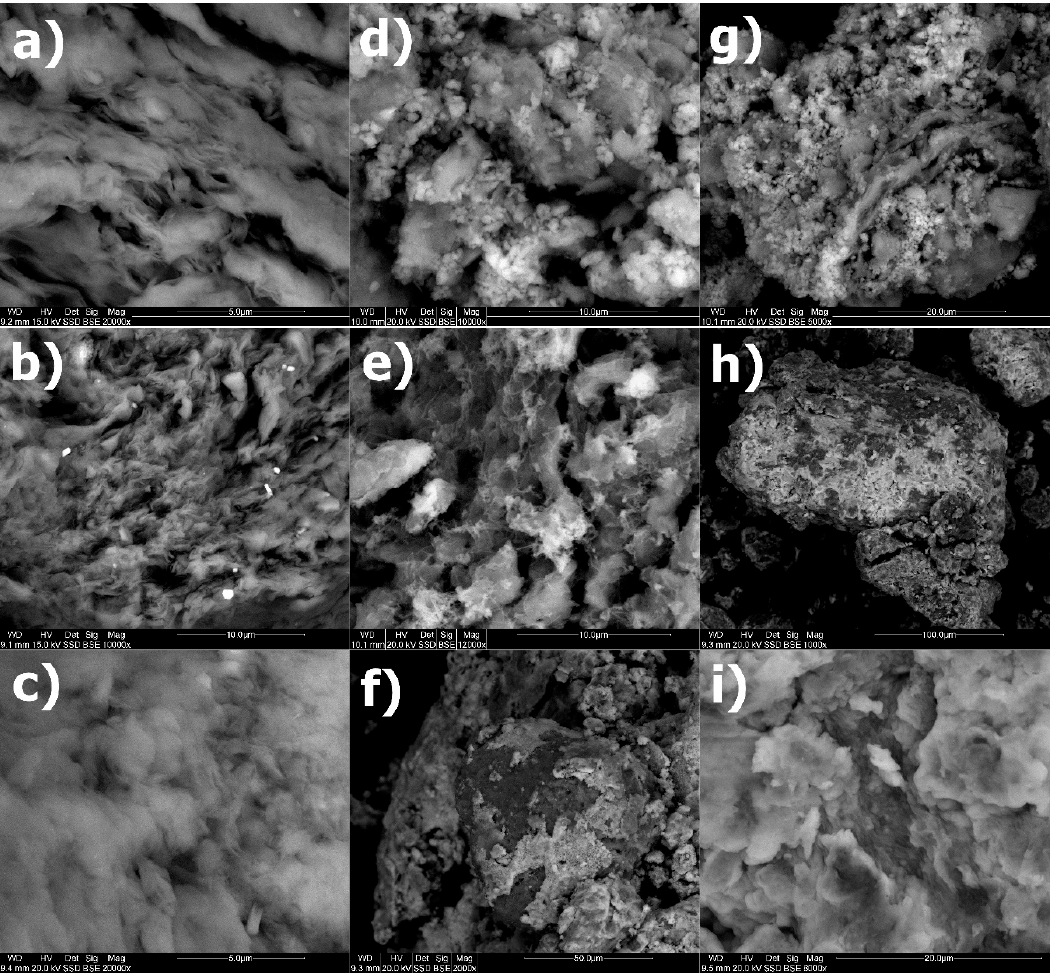
Figure 6. SEM images of samples: ( a ) Na-M, ( b ) DDTMA-M, ( c ) DDDDMA-M, ( d ) DDTMA-M-Mo, ( e ) DDTMA-M-W, ( f ) DDTMA-M-MoW, ( g ) DDDDMA-M-Mo, ( h ) DDDDMA-M-W, ( i ) DDDDMA- M-MoW.